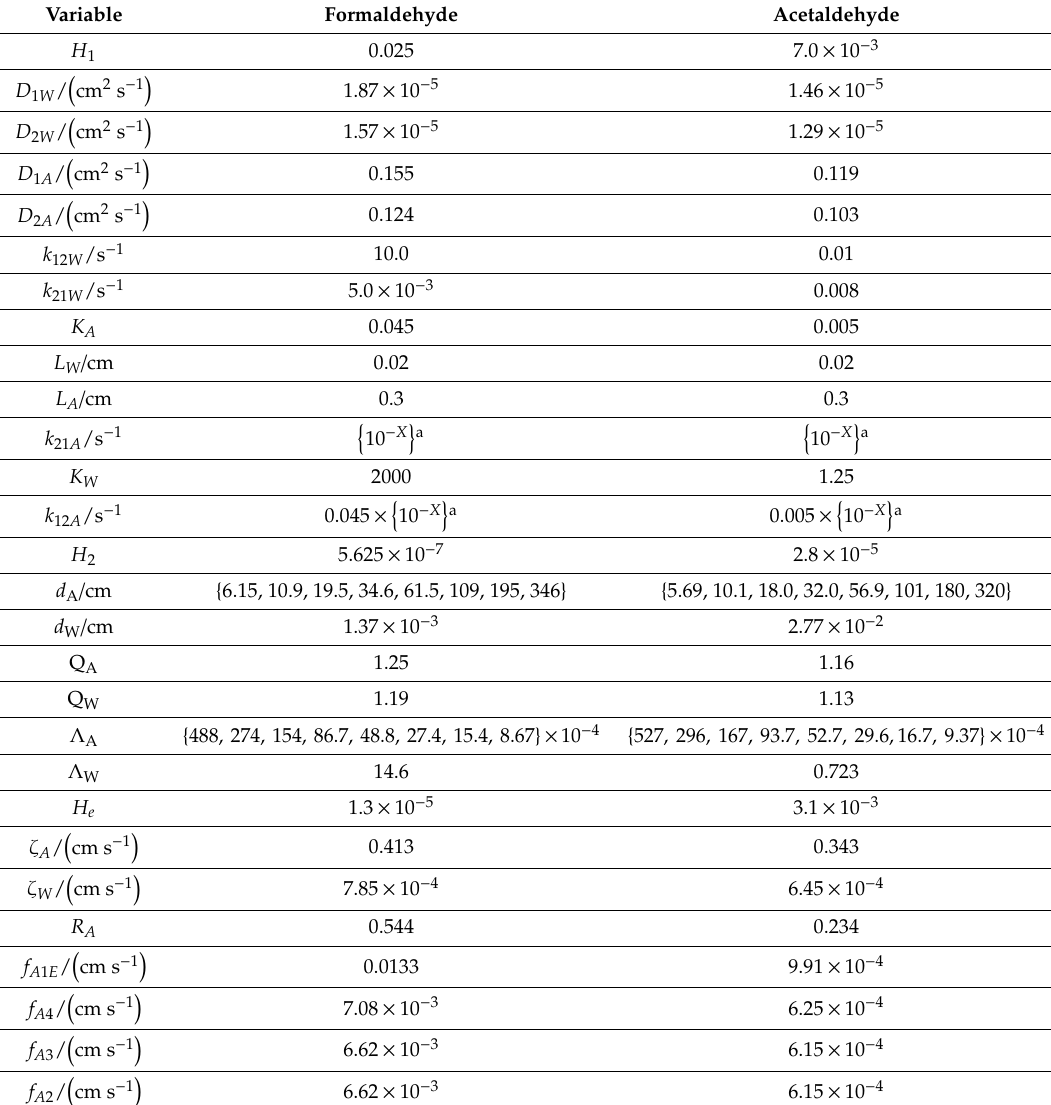
Table 6. Sample calculations. k 21A was allowed to assume eight di ff erent values as indicated. Each of these generated eight di ff erent values for k 12A , d A , and Λ A , but all remaining variables were insensitive to these variations, at least to the number of significant figures